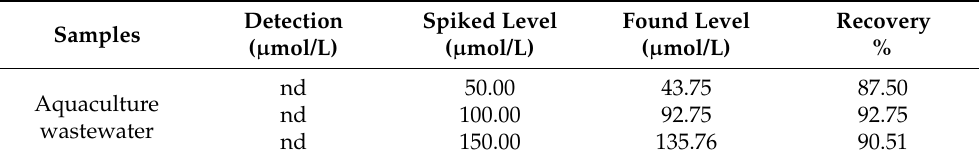
Table 1. Determination of sulfadiazine in an aquaculture wastewater sample.